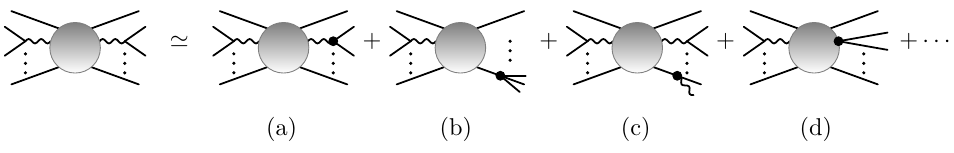
Figure 2 . Decomposing a general scattering amplitude in the SMEFT into pole and non-pole parameters. Here the black dot indicates a possible insertion of the (cid:12)nal states as an illustrative choice, but also appear on the initial states in the suppressed + contributions. A WHZ pole parameter is shown in case